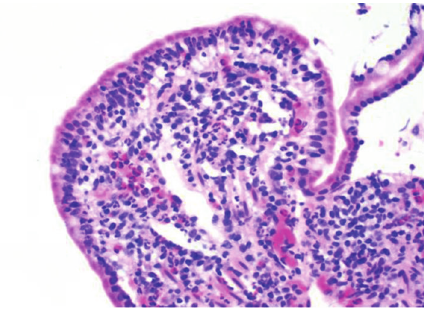
Figure 3: H&E Low power view of second part of duodenal biopsy showing Marsh 3a villous atrophy.